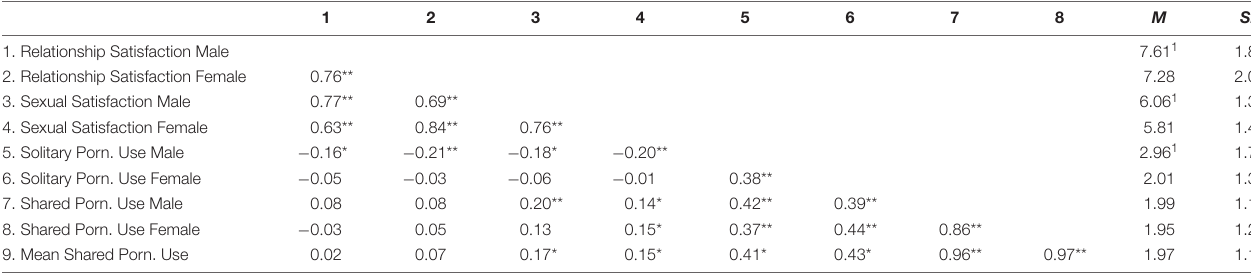
TABLE 5 | Summary of the correlations, means, and standard deviations of the focal variables for Study 3 ( N = 207